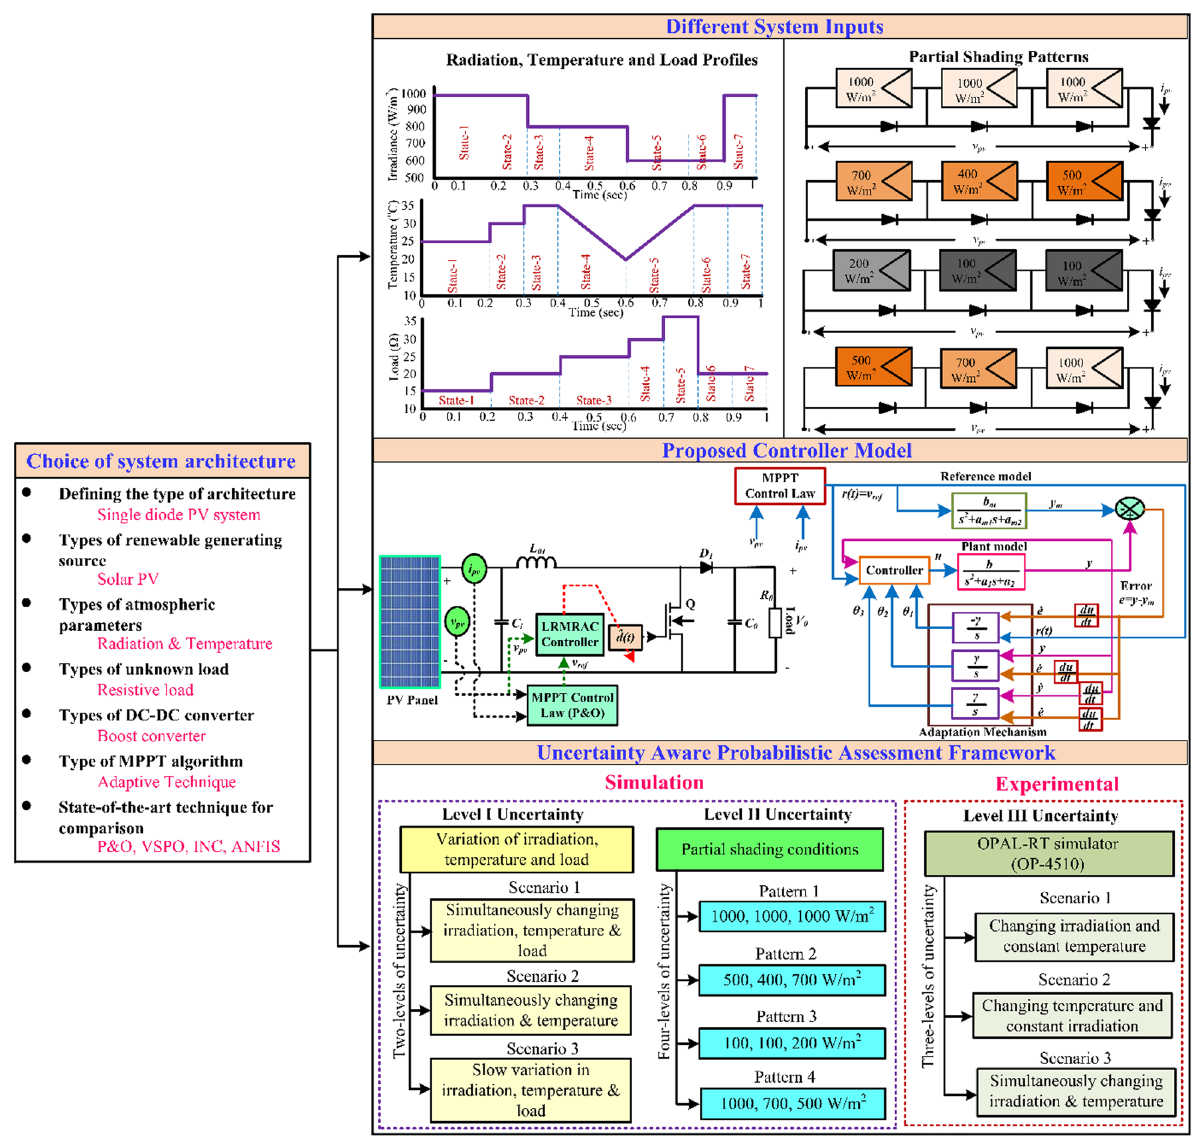
Fig. 1 Graphical representation of structured methodology for the proposed MPPT technique